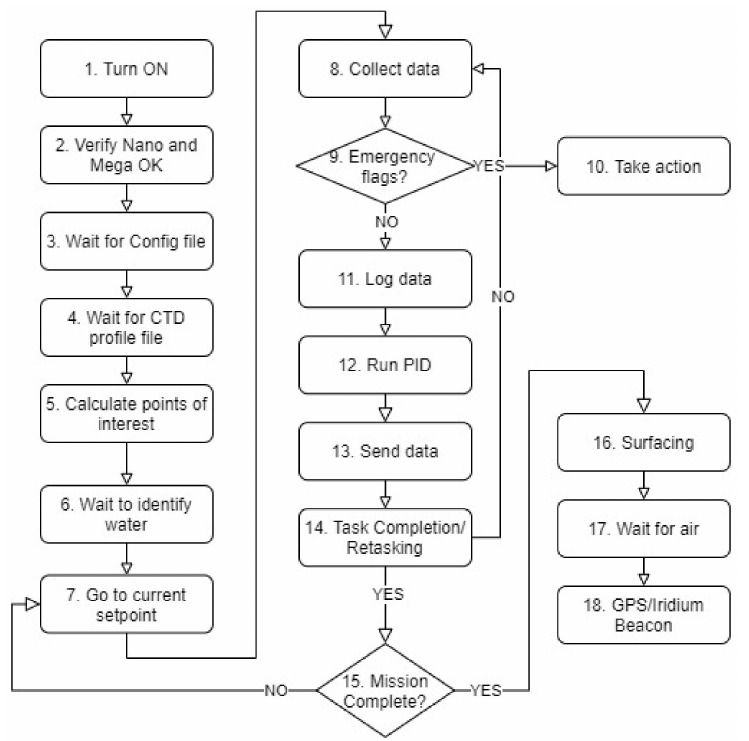
Figure 16. Pi state machine